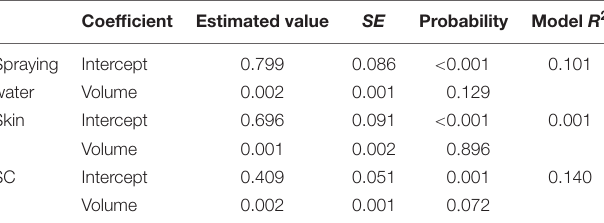
TABLE 1 | Univariate linear regression model for predicting Salmonella typhimurium – choleraesuis reduction in spraying water, skin surface, and subcutaneous of drumsticks exposed to 100, 200, 300, and 500 ml ozonated water of 8 ppm.